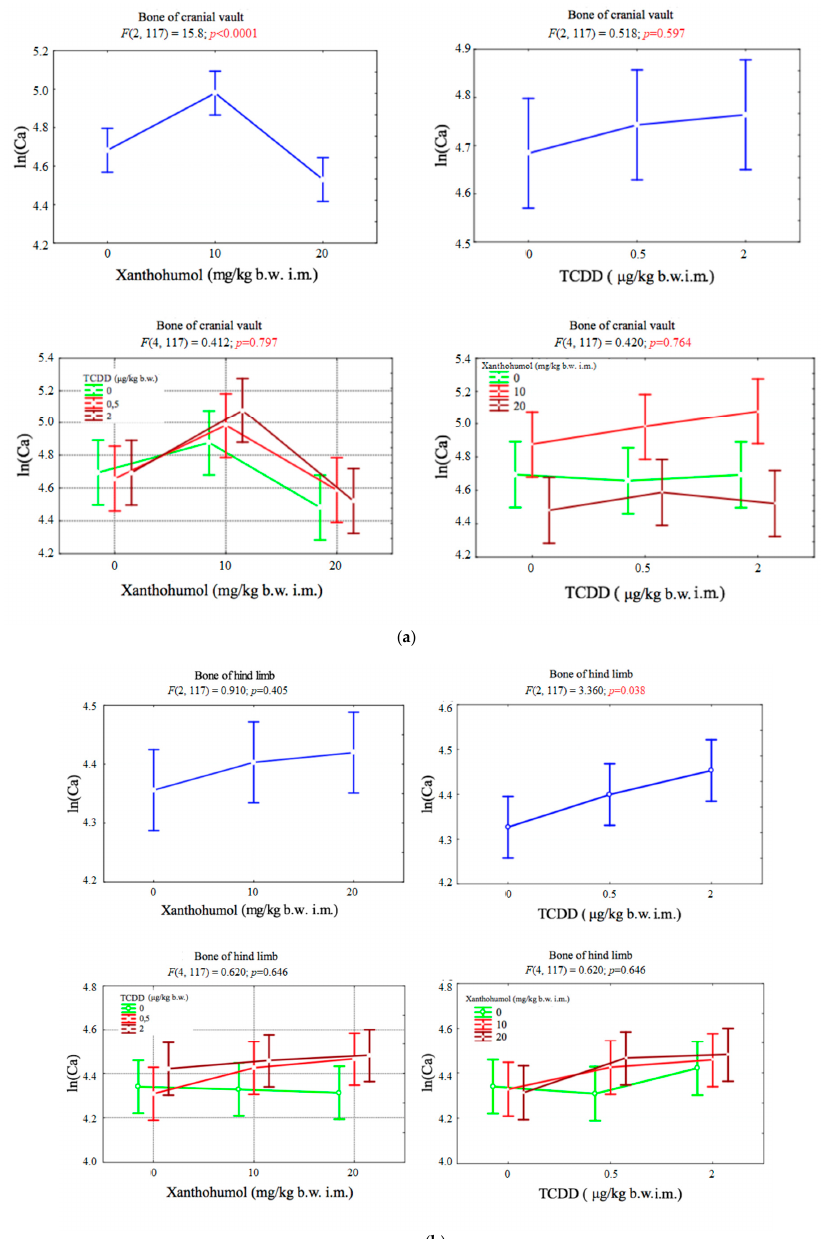
Figure 1. ( a ) Average calcium concentration (transformed variables) in the bone of the cranial vault, depending on the dose of TCDD and xanthohumol, and results of the significance test. Results are represented as mean ± SD. p ≤ 0.05 was considered statistically significant. Significant p value is highlighted in bold. ( b ) Average calcium concentration (transformed variables) in the bone of the hind limb, depending on the dose of TCDD and xanthohumol, and results of the significance test. Results are represented as mean ± SD. p ≤ 0.05 was considered statistically significant. Significant p value is highlighted in bold.